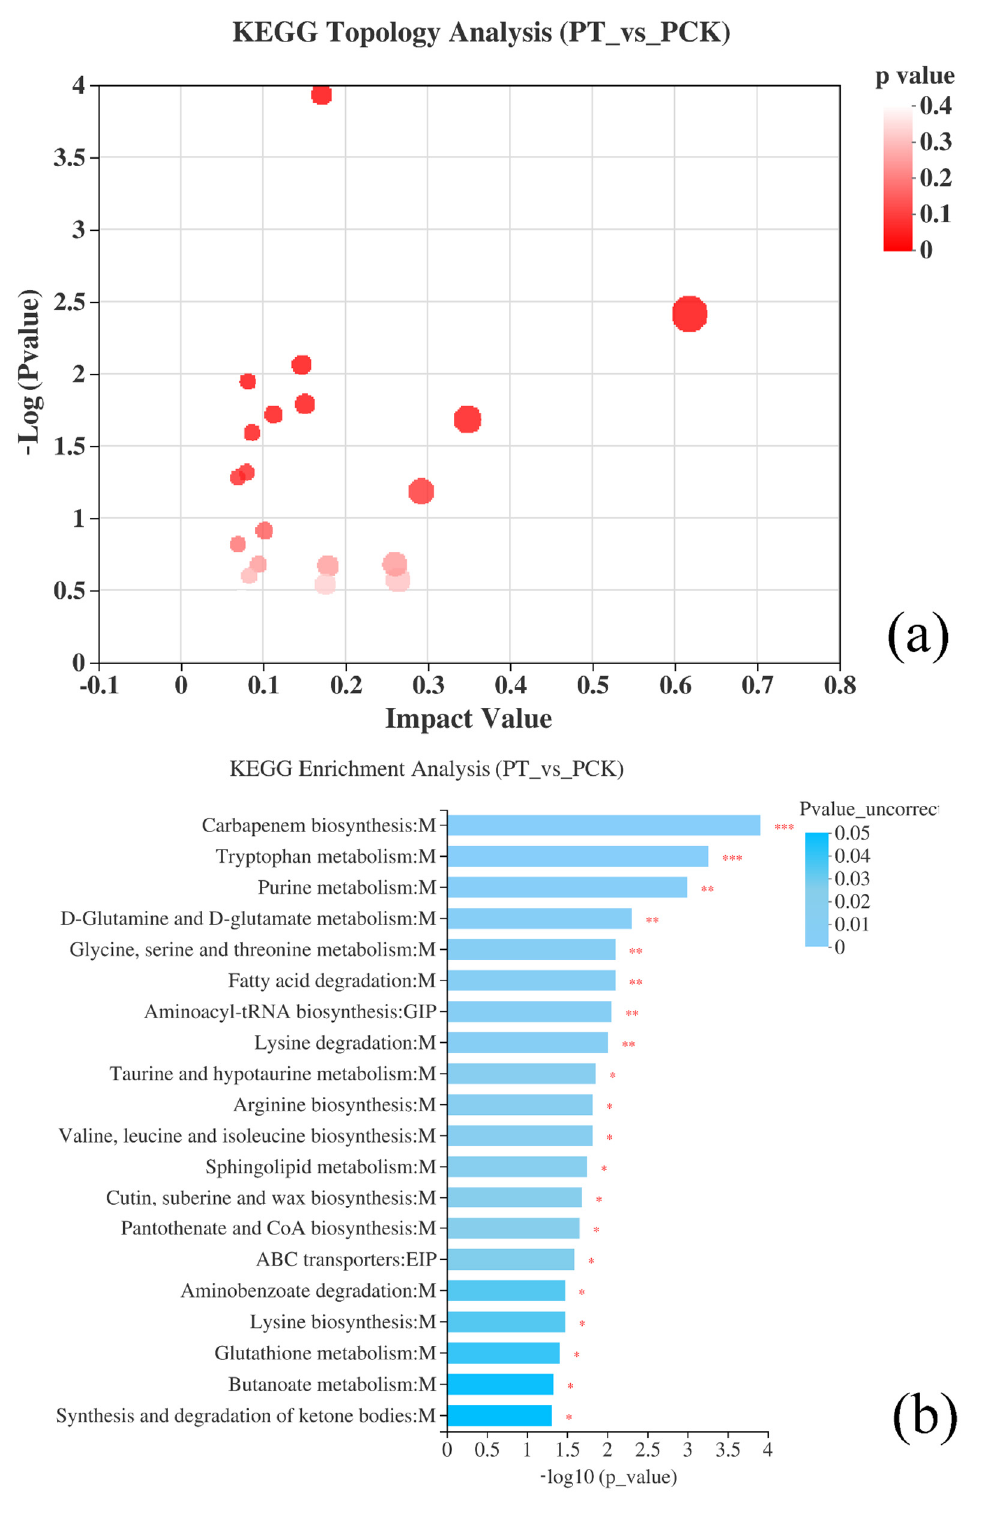
Figure 6. KEGG topology analysis (PT vs. PCK) ( a ), the 20 most enriched ratios of pathway terms of KEGG enrichment in PT vs. PCK groups ( b ). Levels of significance are defined as * p < 0.05, ** p < 0.01, and *** p < 0.001 .